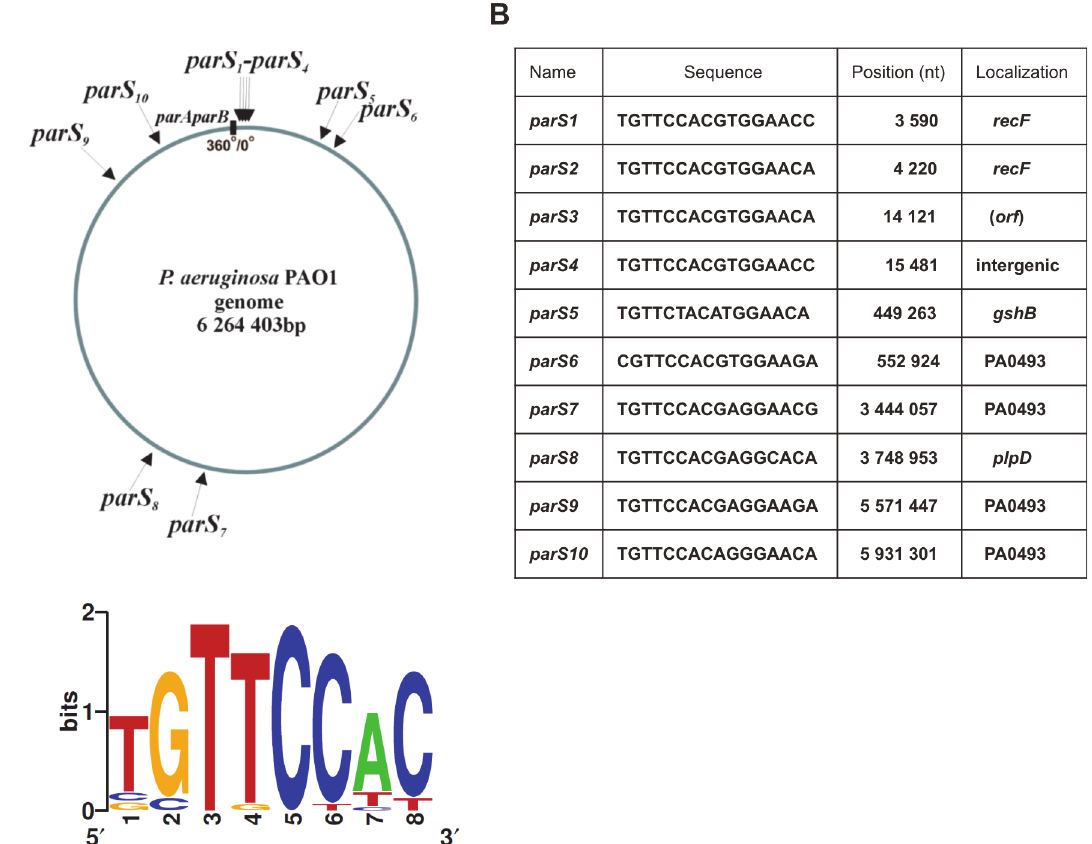
Table 1. Nucleotide substitutions introduced into parS sequences.